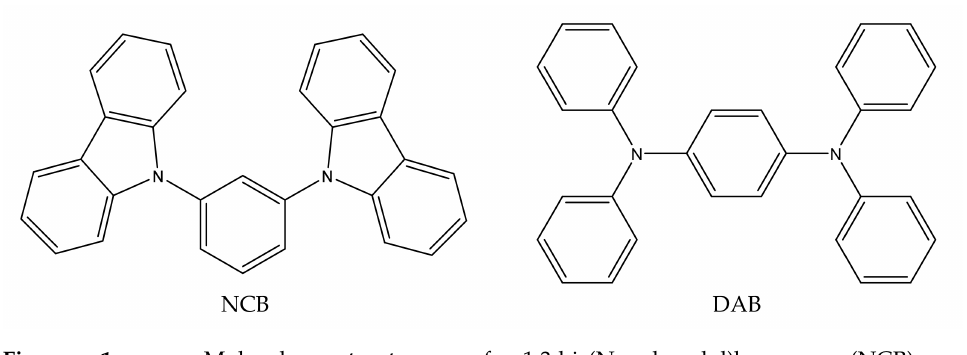
Figure 1. Molecular structures of 1,3-bis(N-carbazolyl)benzene (NCB) and 1,4-bis(diphenylamino)benzene (DAB)